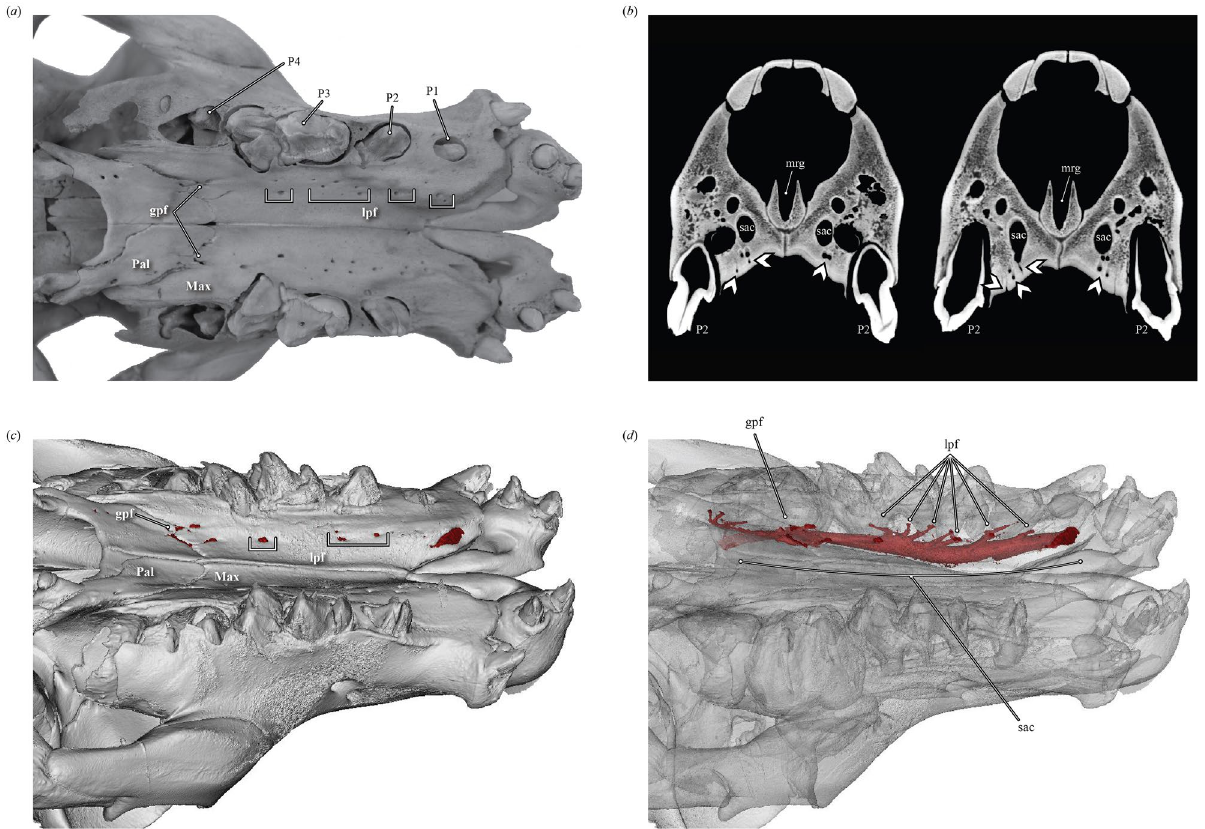
Figure 3. ( a ) Photograph of the skull of UMMZ 101782, juvenile Hippopotamus amphibius , in ventral view. Gpf: greater palatine foramen; lpf: lateral palatine foramina; Pal: Palatine; Max: Maxilla. ( b ) Cross sectional CT scans through the skull of UMMZ 101782 at the level of the second premolar. White label denotes the mesorostral groove (mrg) and white arrows point to the internal canals that are confluent with the lateral palatal foramina, demonstrating that they connect to the superior alveolar canal (sac). ( c ) 3D model of the skull of UMMZ 101782 in oblique view. External bony surface is shown in white and foramina are shown in red. ( d ) 3D model of the skull of UMMZ 101782 in oblique view, with the external bony surface made transparent to illustrate the canal system that connects to the lateral palatal foramina (lpf). Lateral palatal foramina are all positioned anterior to and are unrelated to the greater palatine foramen (gpf), which exits the skull near the palatine-maxillary We also tested if the number of palatal foramina significantly differs across the relevant clades (terrestrial artiodactyls, stem cetaceans, odontocetes, and mysticetes) by conducting two one-way ANOVAS. The first tested the respective clades as the independent variable against the total number of clusters of palatal foramina (Table S1, TPF) as the dependent variable. The second tested the respective clades as the independent variable against the number of major palatal foramina (Table S1, MPF) as the dependent variable. We report statistically significant differences in the total number of clusters of palatal foramina across the relevant clades ( p = 0.00085, F = 13.06, df = 3). Specifically, a posthoc Tukey’s test demonstrates that terrestrial artiodactyls have significantly more clus- ters of palatal foramina than odontocetes or stem cetaceans, while mysticetes did not differ significantly from any of the other three groups in the number of palatal foramina. Conversely, we find no significant differences between the number of major palatal foramina (> 1 mm diameter) across the four groups ( p = 0.359, F = 1.09, df = 3). To further test the differences among clades we measured the diameter of every observed major palatal foramen (> 1 mm diameter). We conducted an additional one-way ANOVA testing the four distinct clades (Artiodactyla, stem Cetacea, Mysticeti, and Odontoceti) as the independent variable against the size of the major palatal foramina as the dependent variable (Table S3). We report significant differences in the size of the palatal foramina across groups ( p = 1.64 × 10 −10 , F = 17.16, df = 3). A posthoc Tukey’s Test demonstrates that the size of the palatal foramina in mysticetes differs significantly from the size of the palatal foramina in odontocetes and terrestrial artiodactyls, while those belonging to stem cetaceans are not significantly different from either of the other groups. The closest living relative of cetaceans, Hippopotamus amphibius , exhibits some of the most prominent lat- eral palatal foramina observed (Figs. 3, 4). Each observed specimen of Hippopotamus , including one juvenile, preserves over a dozen major lateral palatal foramina that span the length of the tooth row and in some cases